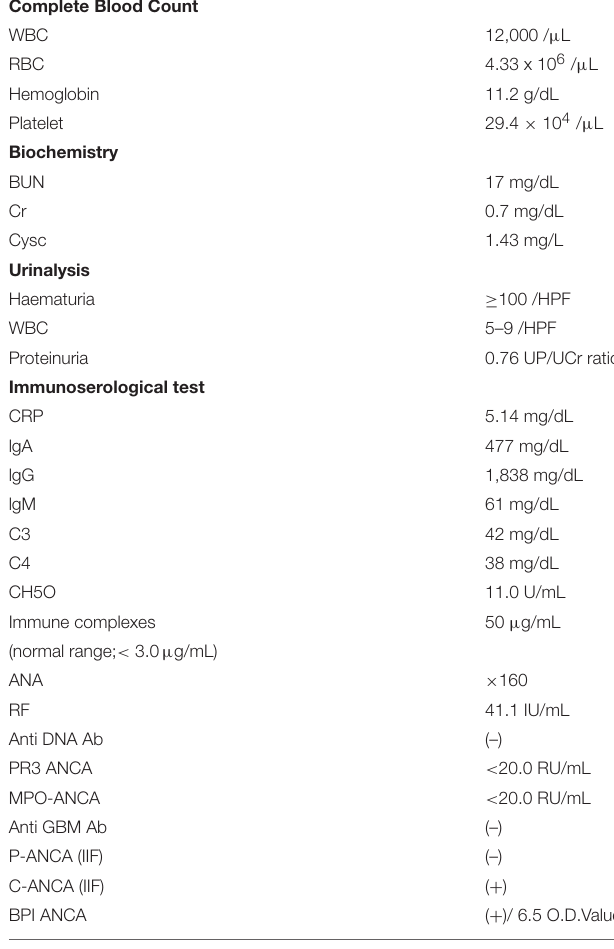
TABLE 1 | Laboratory